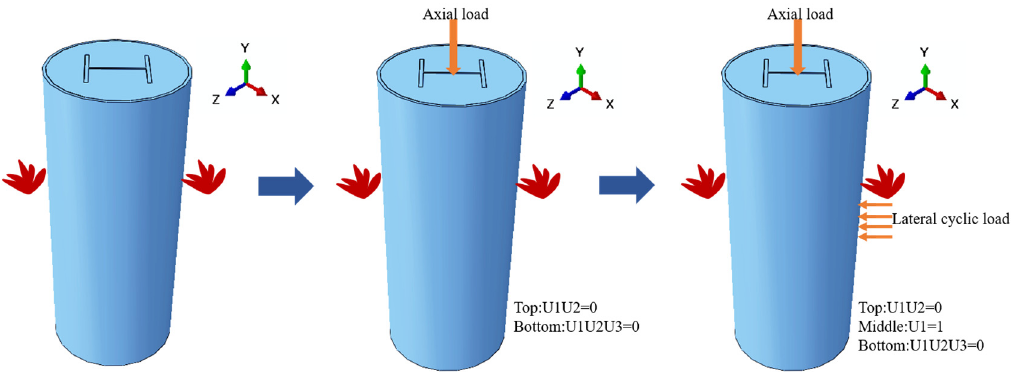
Figure 2. Numerical calculation steps and loading illustration.